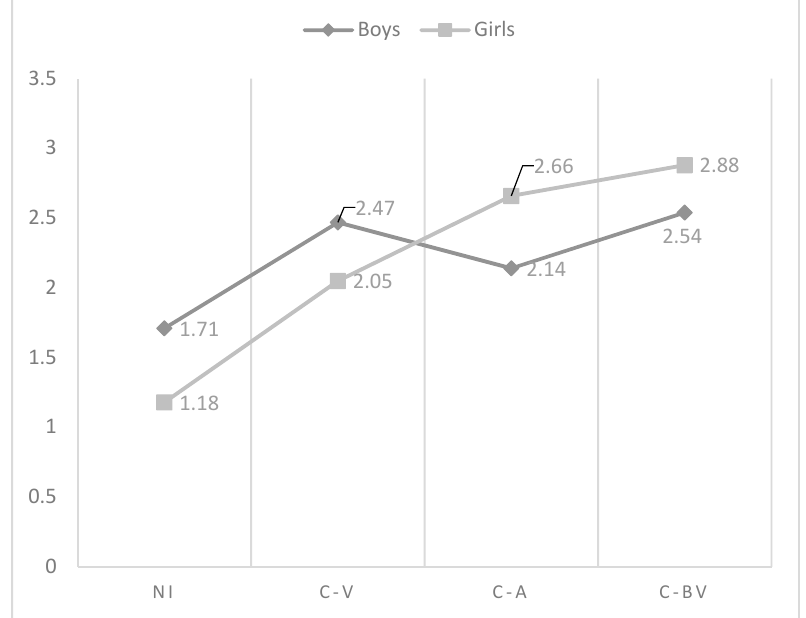
Figure 4. Effect of the interaction of gender and cyberbullying roles on mother punishment. Notes: NI = Non-involved; C-V = Cyber-victim; C-A = Cyber-Aggressor; C-BV = Cyber-bully/victim.